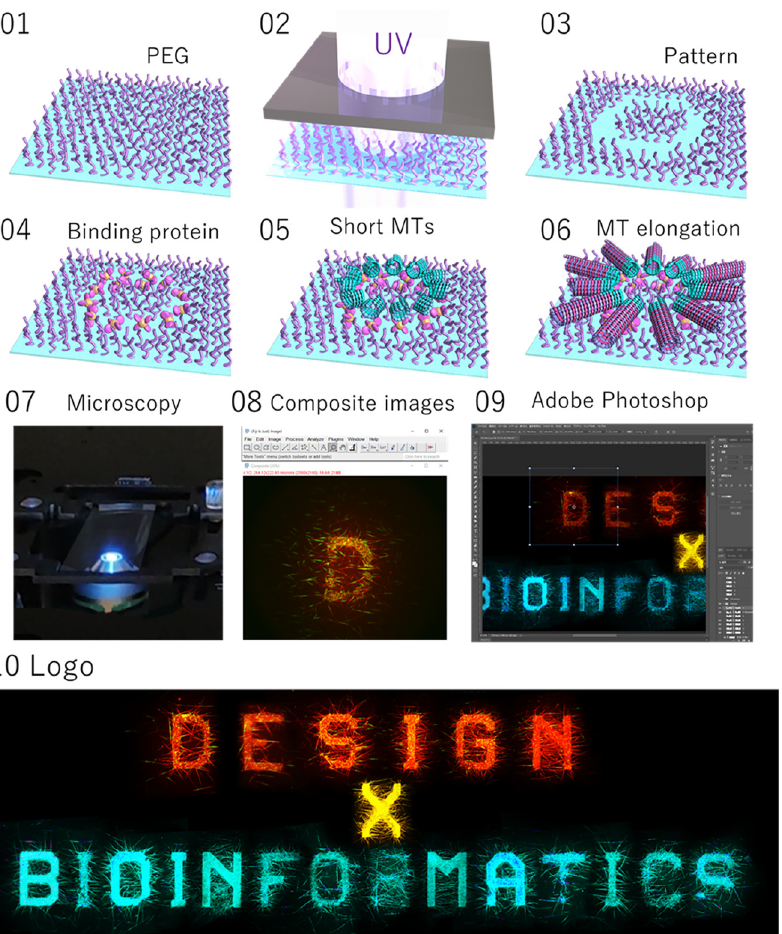
Figure 1: The creation of the workshop logo: the workshop logo was created using the micropatterning technique of microtubules (MTs) on a glass substrate grafted with polyethylene glycol (PEG) (steps 01 to 06). Partial removal of PEG by UV irradiation via a photomask enables patterning of microtubules on the glass surface. Images of the microtubule letter patterns were captured under a fluorescence microscope (step 07), followed by image processing in image J and adobe photoshop to create the final logo image (steps 08 and